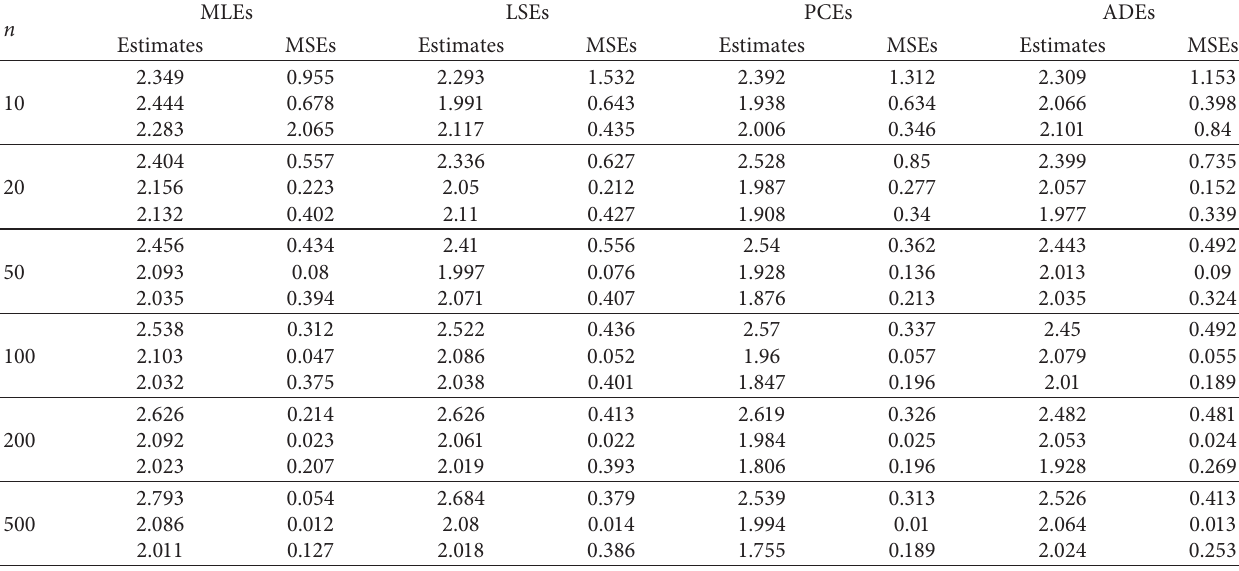
Table 6: Estimates and MSEs of the OFIL distribution for MLEs, LSEs, PCEs, and ADEs for set 5 ( α � 3 , θ � 2 , and β � 1 . 5). MLEs n